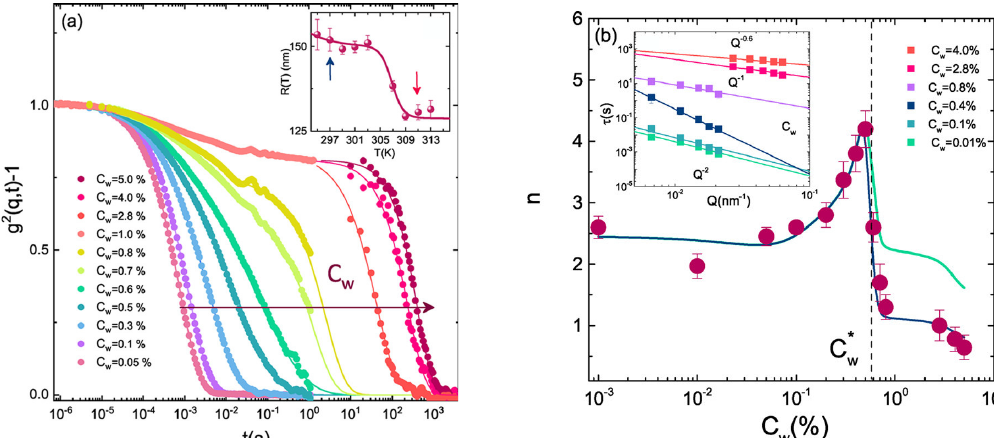
Figure 8. ( a ) g 2 functions from interpenetrating networks of microgel particles at T = 311 K and q = 0.022 nm − 1 at different concentrations. The inset shows the temperature dependence of the hydrodynamic radius measured by DLS at low concentrations. ( b ) Exponent n showing the q -dependence of the relaxation rate ( τ ∝ q − n ). The inset shows the relaxation times as a function of q for selected concentrations. Reprinted with permission from Nigro et al. Macromolecules 2020,